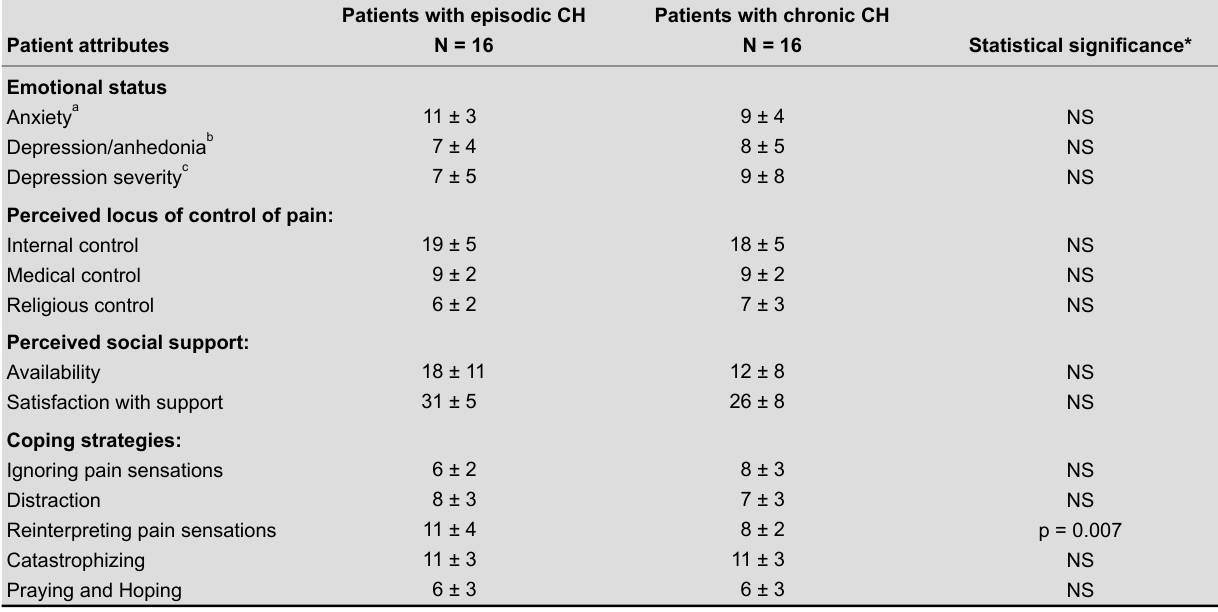
Comparison of the Groups of Patients with Episodic or Chronic Cluster